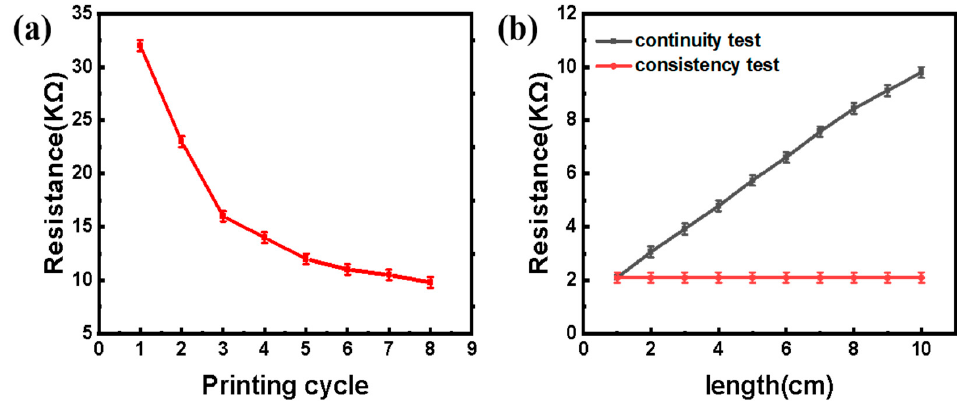
Figure 7. ( a ) Resistance of the graphene/PVA-g-PANI ink at different printing cycles; ( b ) resistance consistency and continuity of the graphene /PVA-g-PANI ink.